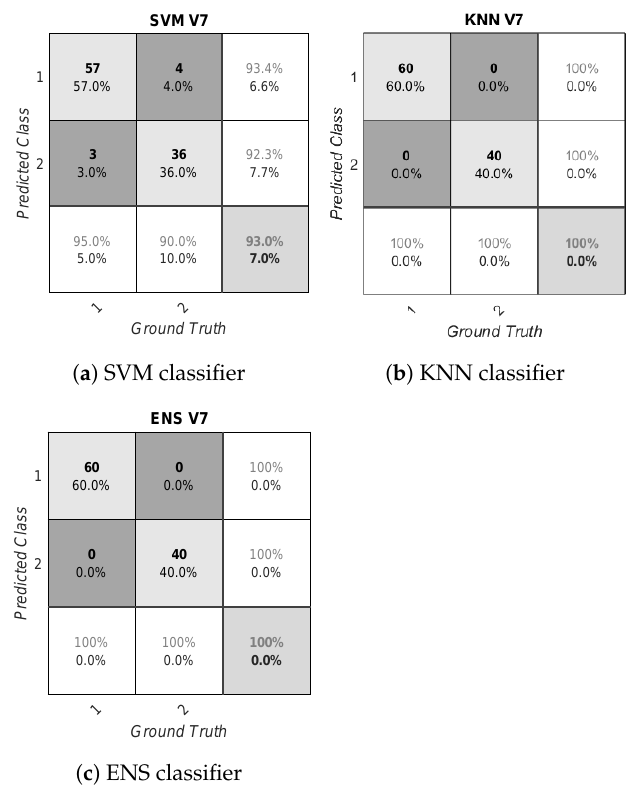
Figure 4. Confusion matrices for a subject-dependent model in